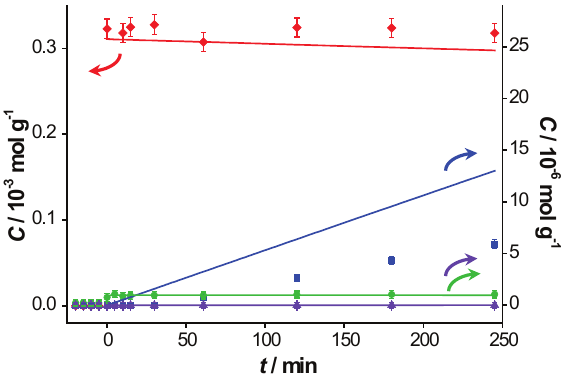
Figure 4. Catalyst performance after pre-addition of benzoic acid. Concentration of ( ♦ ) benzyl alcohol, ( ■ ) benzaldehyde, ( ● ) benzoic acid and ( ▲ ) benzyl benzoate vs. reaction time for catalytic reaction over fresh AUROlite ™ . Benzoic acid was introduced 20 min prior to the beginning of the reaction. Reaction conditions: T = 80 °C, 0.8 g AUROlite ™ , C = 3.0 × 10 − 4 mol · g − 1 , C = 4.1 × 10 − 6 mol · g − 1 , in 80 mL of toluene, BnOH, t=0 BnOOH, t<0 200 mL · min − 1 air flow. Concentrations are expressed in moles per unit mass of liquid in the reactor (mol · g − 1 ). The symbols with error bars are the experimental results and the lines represent the kinetic